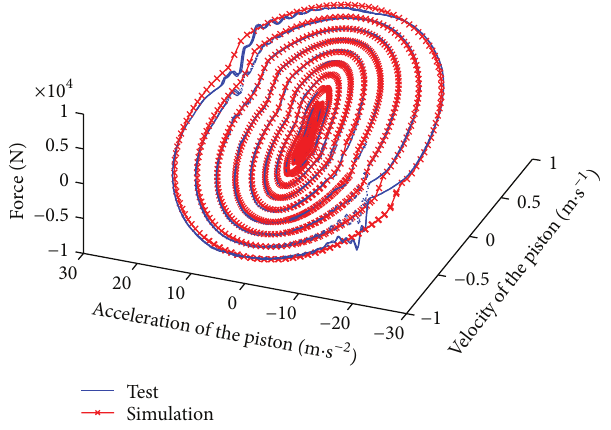
Figure 11: Three-dimensional comparisons under the same excitation conditions.